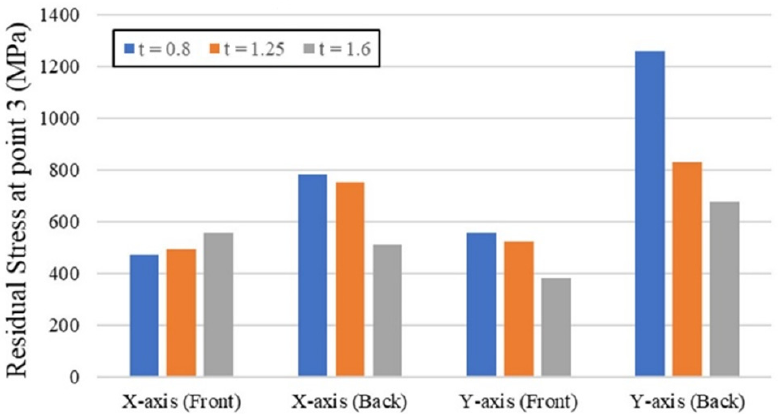
Figure 9. Residual stresses at point 3 for different polymer core thicknesses.